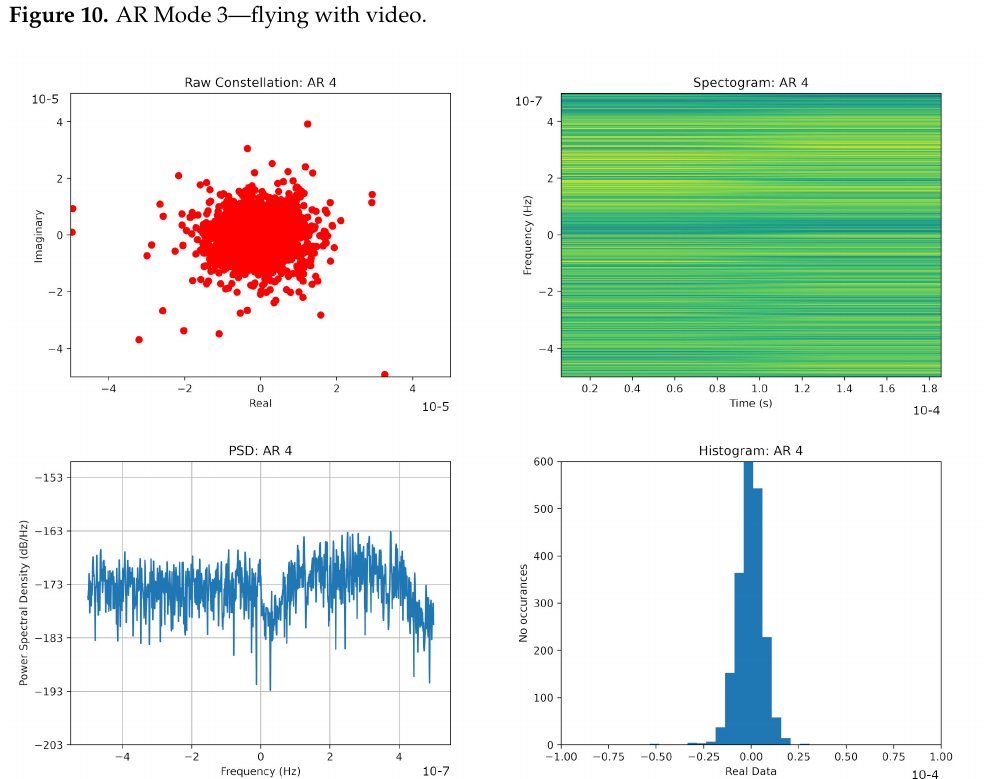
Figure 11. AR Mode 4—flying with